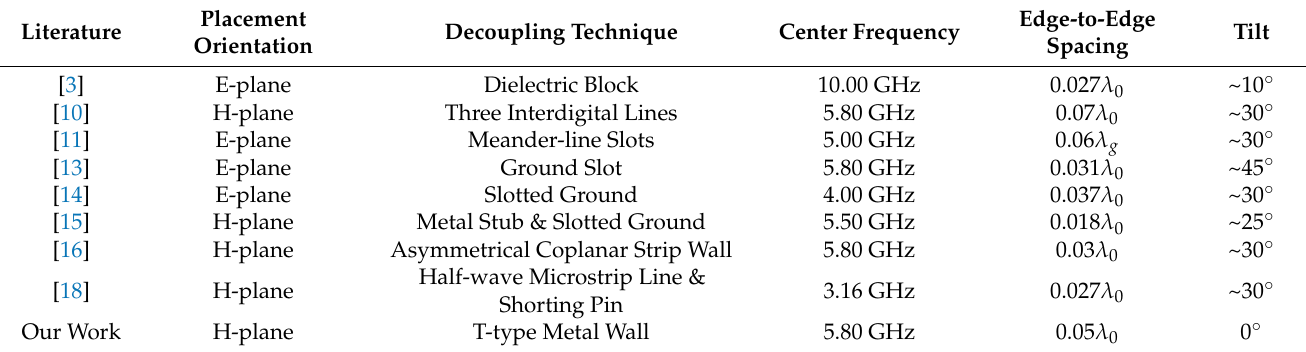
Table 2. Comparisons with other works.